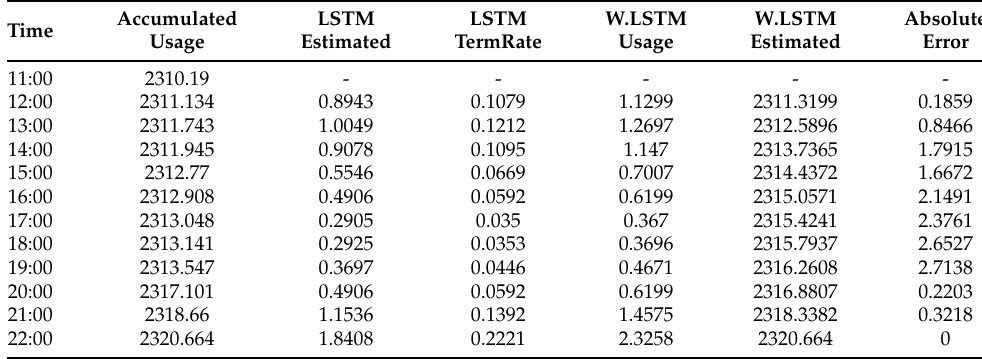
Table 9. Data corrected by applying the LSTM estimates and weights.